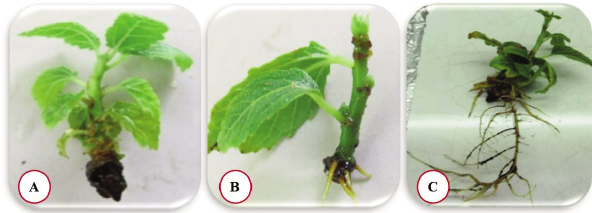
Fig. 4 - Effects of IBA on rooting of shoots in ‘Bargchenari’ geno- type in in vitro condition, A= control, B= 0.5 mg l -1 IBA on MS medium, C= 1.5 mg l -1 IBA on MS 1/2